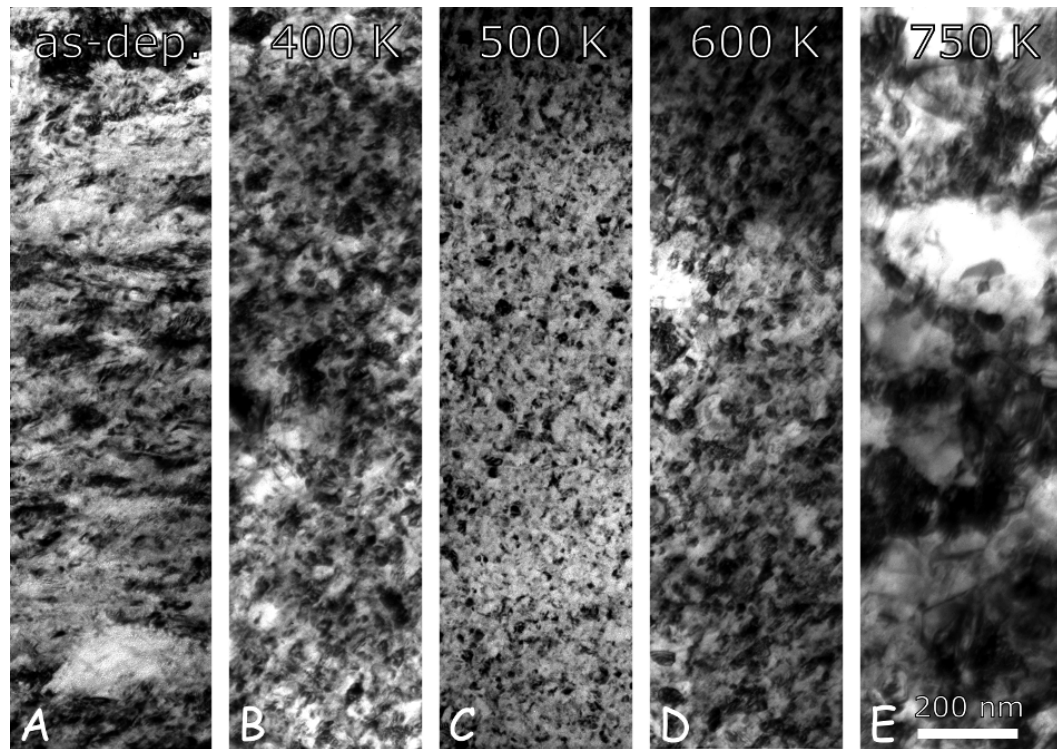
Figure 7. Plane view TEM images showing the microstructures on the “es” side of the CYS04 film in the as-deposited state ( A ) and after annealing at 400 ( B ), 500 ( C ), 600 ( D ) and 750 K ( E ).